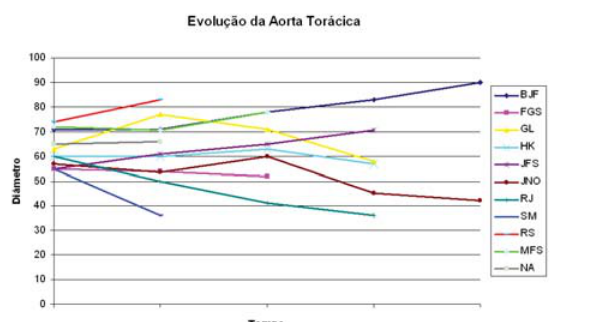
Fig. 1 - Evolução dos maiores diâmetros da porção torácica da aorta no decorrer do